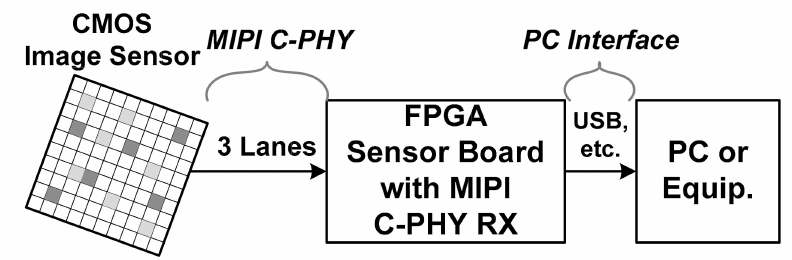
Figure 1. High-speed interface of FPGA-based frame grabber for CMOS image sensor.